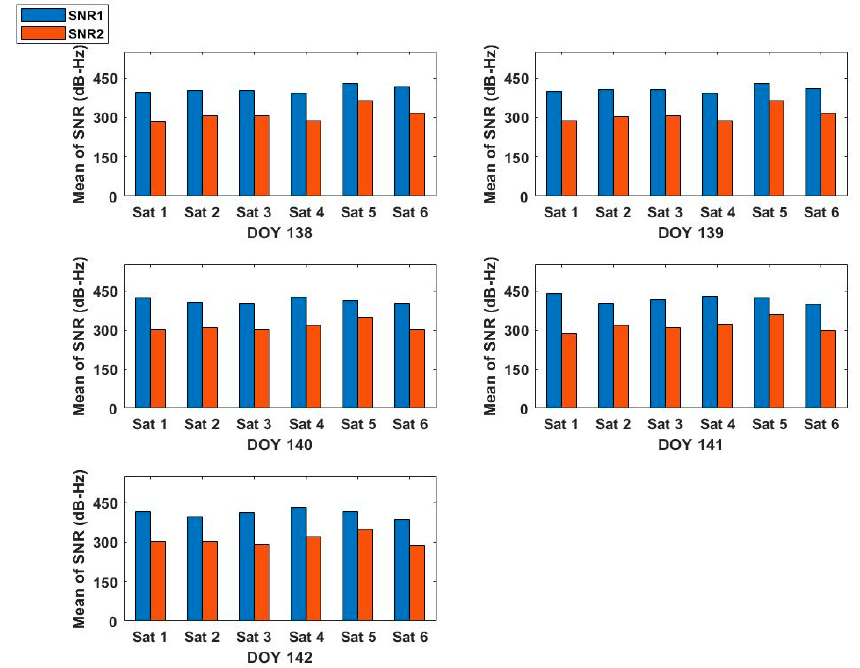
Figure 3. Mean SNR of each COSMIC-2 satellite during DOY 138–142, 2021.